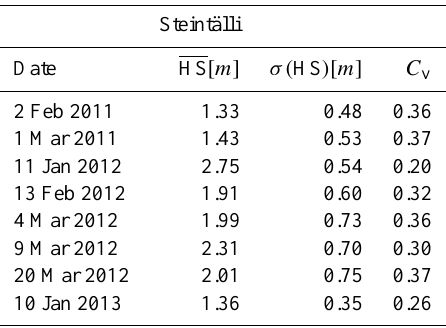
Table 1. Mean HS, standard deviation σ( HS ) and coefficient of variation C v of snow depth distribution for every laser scan acqui- sition in the ST basin.